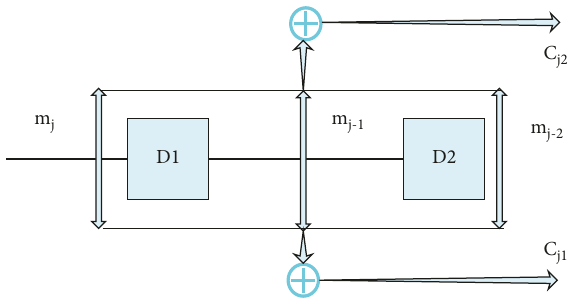
Figure 9: Encoder with (2, 1, 2) convolutional